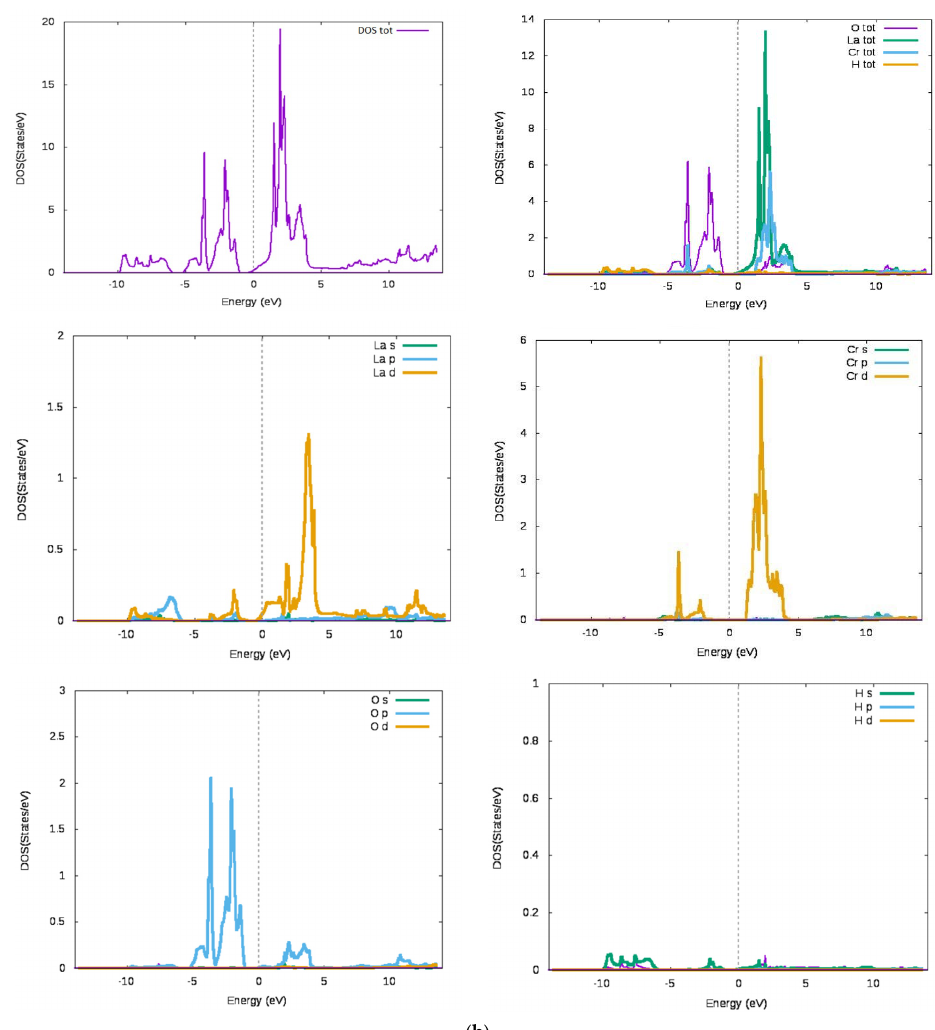
Figure 1. ( a ) Representation of the total and partial density of states of LaCrO 3. ( b ). Total and partial density of states of LaCrO 3 H 6.